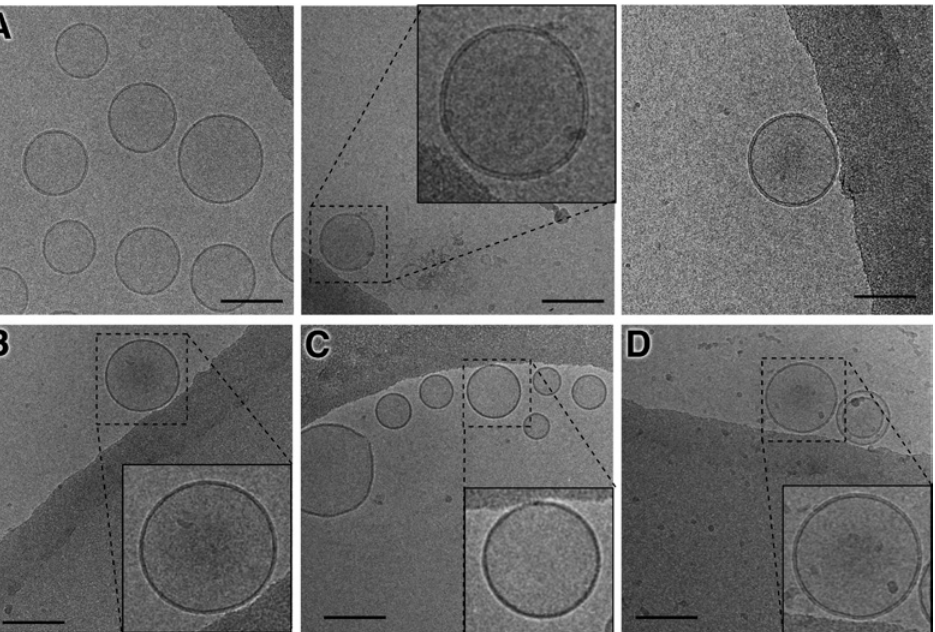
Figure 3: Encapsulation of fluorescent dye and heavy metal chemicals investigated by cryo-EM. (A) Control. E. coli polar lipid extract lipo- some with the same buffer system (20 mm Tris-HCl pH 7.6, 1 mm EDTA) on both sides of the bilayer. Under these conditions, the image con- trast and noise distribution should be uniform inside and outside of the liposome (left and center). The two leaflets of the lipid bilayer can be distinguished (inset). A contrast gradient in the liposome lumen that increases towards the center indicates that the liposome protruded from the vitrified layer and collapsed (right), i.e. it is a grid-preparation artifact. (B–D) Encapsulation. E. coli polar lipid extract liposomes were formed in 20 mm Tris-HCl pH7.6, 1 mm EDTA buffer, containing the indicated additional component and dispersed in the same buffer without it. (B) The fluorescent dye CF, 100 mm. (C) CsCl, 100 mm. (D) FeCl , 100 mm. Encapsulation could not be visualized by cryo-EM. The 3 increased contrast towards the center of liposomes shown in B and D is a grid preparation artifact, as discussed in (A). Insets: magnified views of the indicated liposomes. Equivalent results were obtained with DMPC liposomes under the same buffer conditions. Scale bars: 100